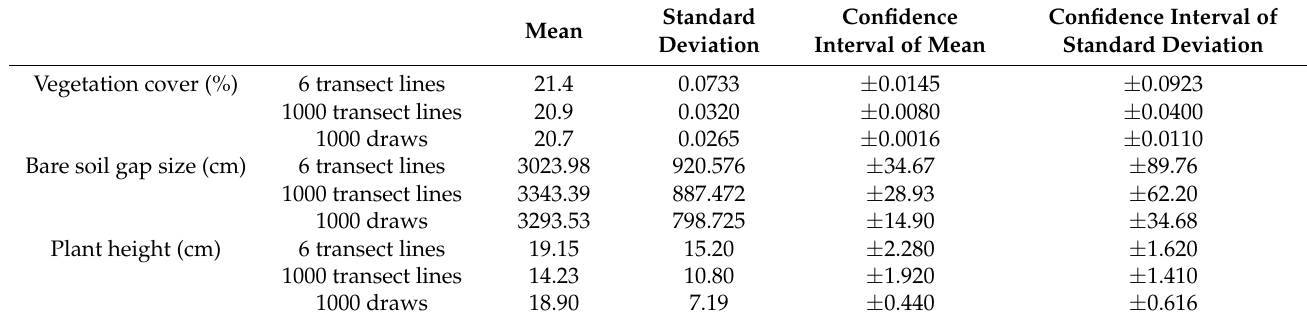
Table 3. The mean, standard deviation, confidence interval of mean, and confidence interval of standard deviation of 6 and 1000 evenly distributed transect lines and 1000 draws for vegetation cover, bare soil gap size, and plant height.